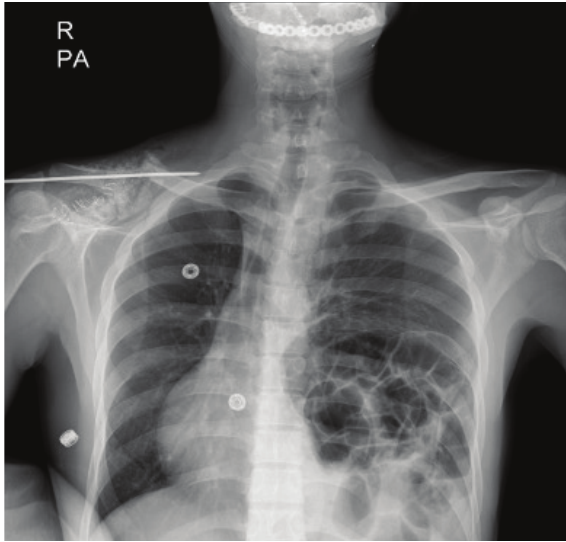
Figure 2 - Preoperative clavicle fracture and raised bowel loops secondary to diaphragmatic